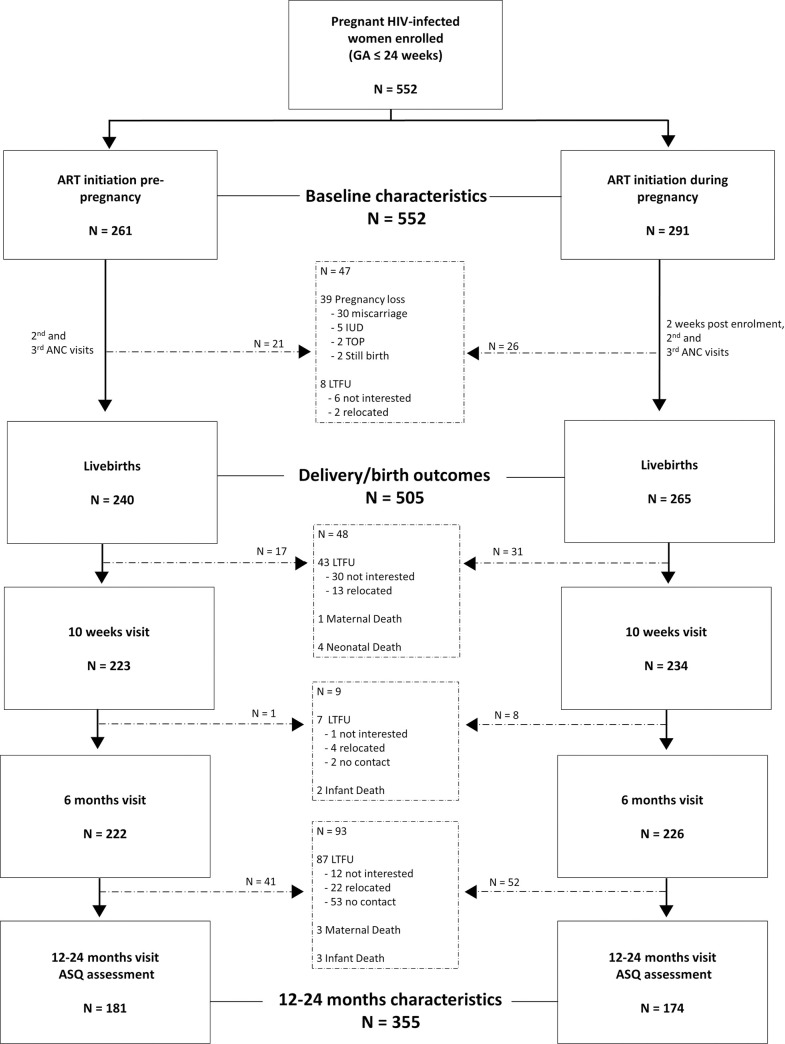
Flow diagram showing participant enrolment and retention at different study visits by maternal ART initiation status.GA—gestational age, ART—antiretroviral therapy, IUD—intrauterine death, TOP—termination of pregnancy, ANC—antenatal care, LTFU—loss to follow up, ASQ—Ages & Stages Questionnaire.